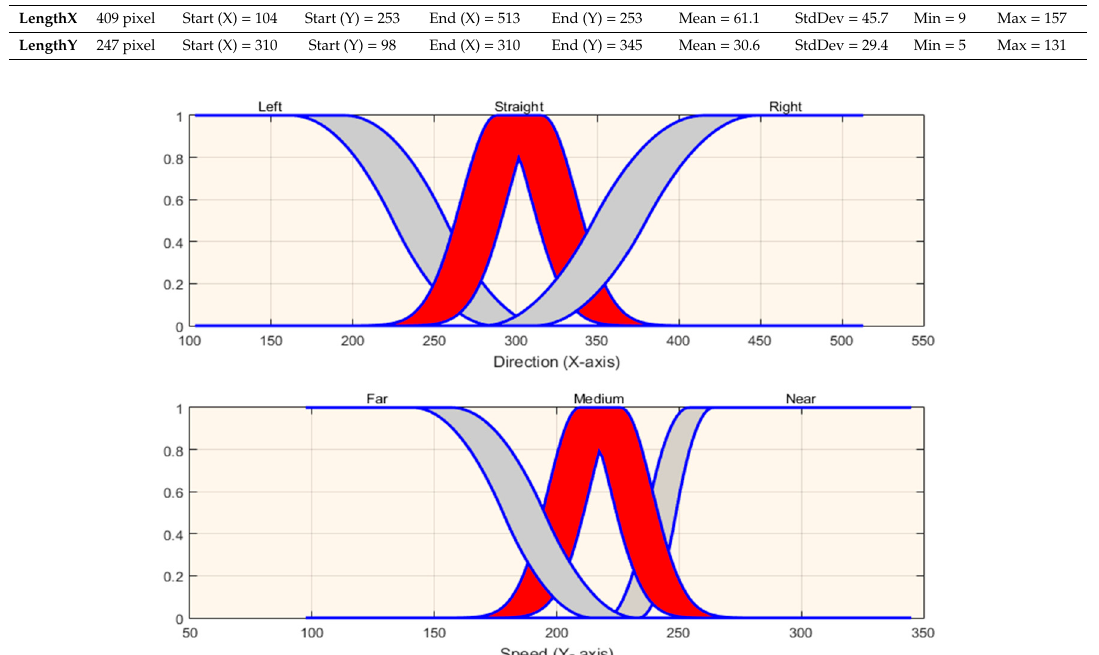
Table 1. Eye region information.